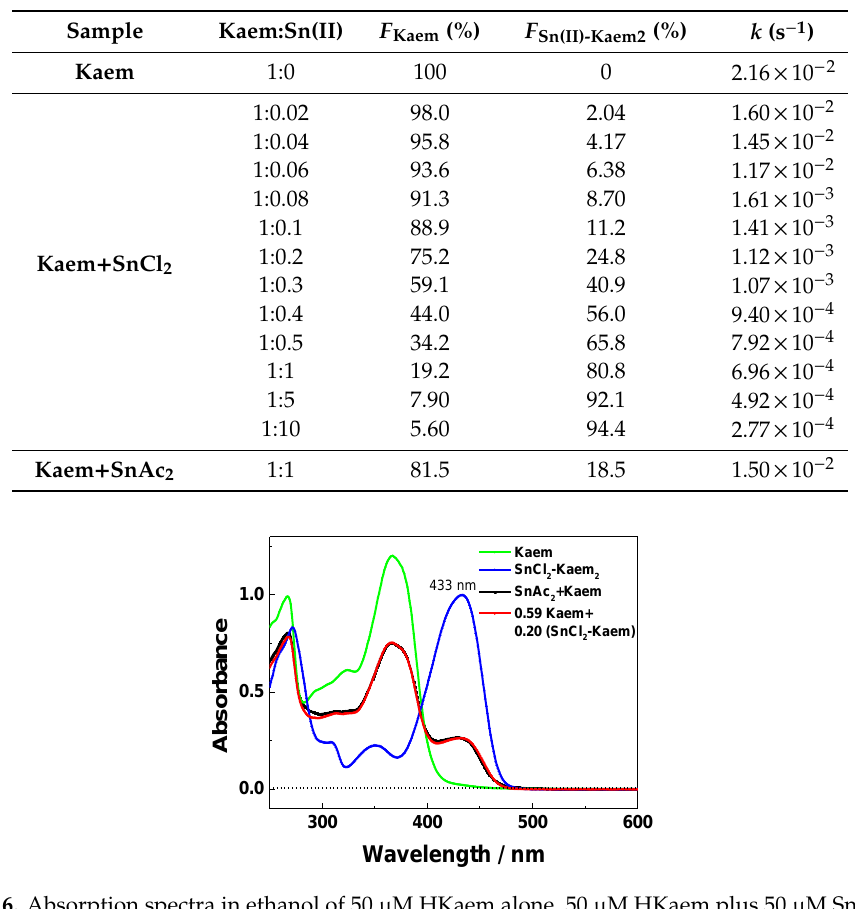
Table 2. Fractions ( F , %) of Kaem and [Sn(II)(Kaem) 2 ] and initial rate k (s − 1 , including k 1 and k 2 from Equations (5) and (6)) of DPPH • scavenging by100 µ M HKaem, by solutions of 100 µ M HKaem and SnCl 2 at indicated varying ratios, and by a solution of 100 µ M HKaem and 100 µ M Sn(OAc) 2 in ethanol. Sample Kaem:Sn(II)